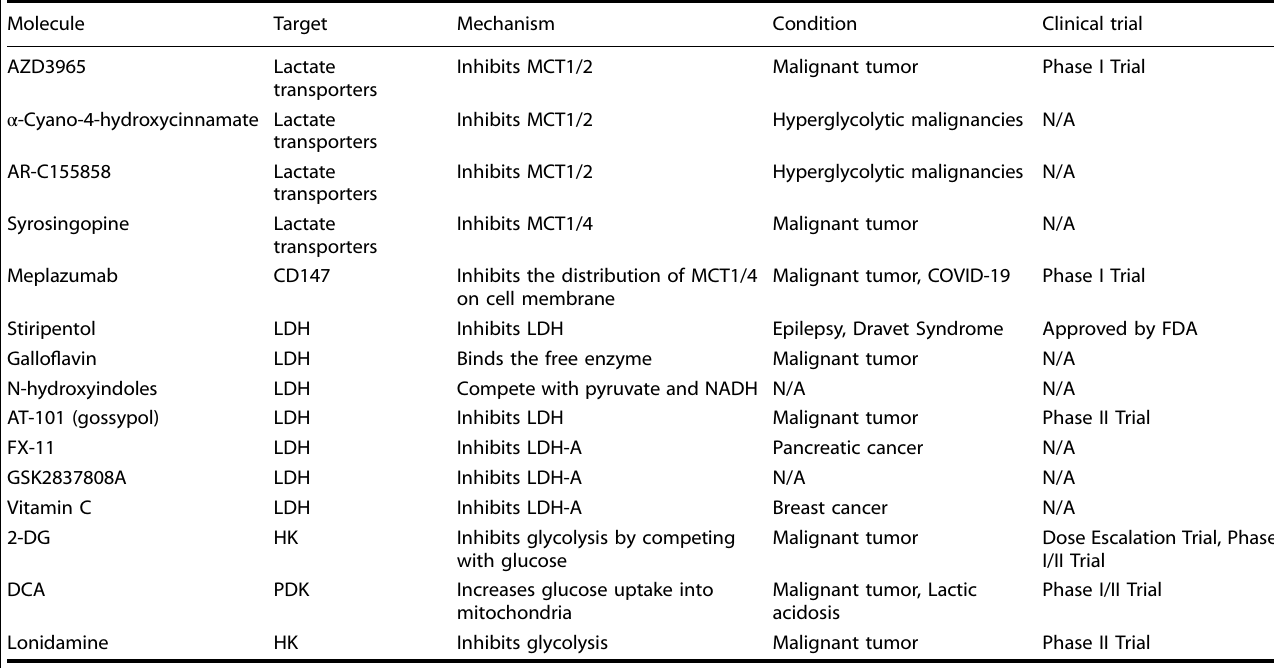
Table 4. Drugs that target production and transport of